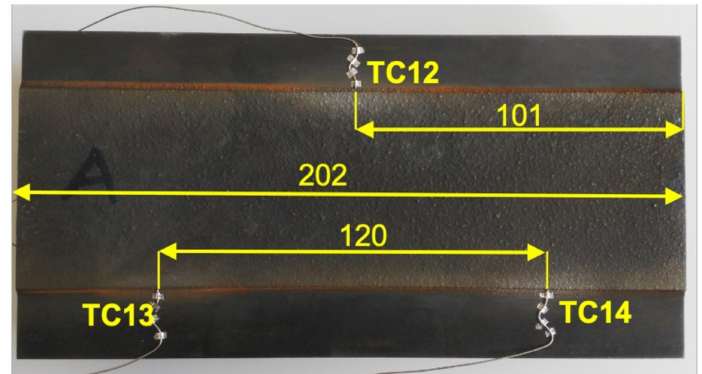
Figure 6. Experimental set-up for determining the correlation between IR camera temperature readings and the real surface temperature for tungsten